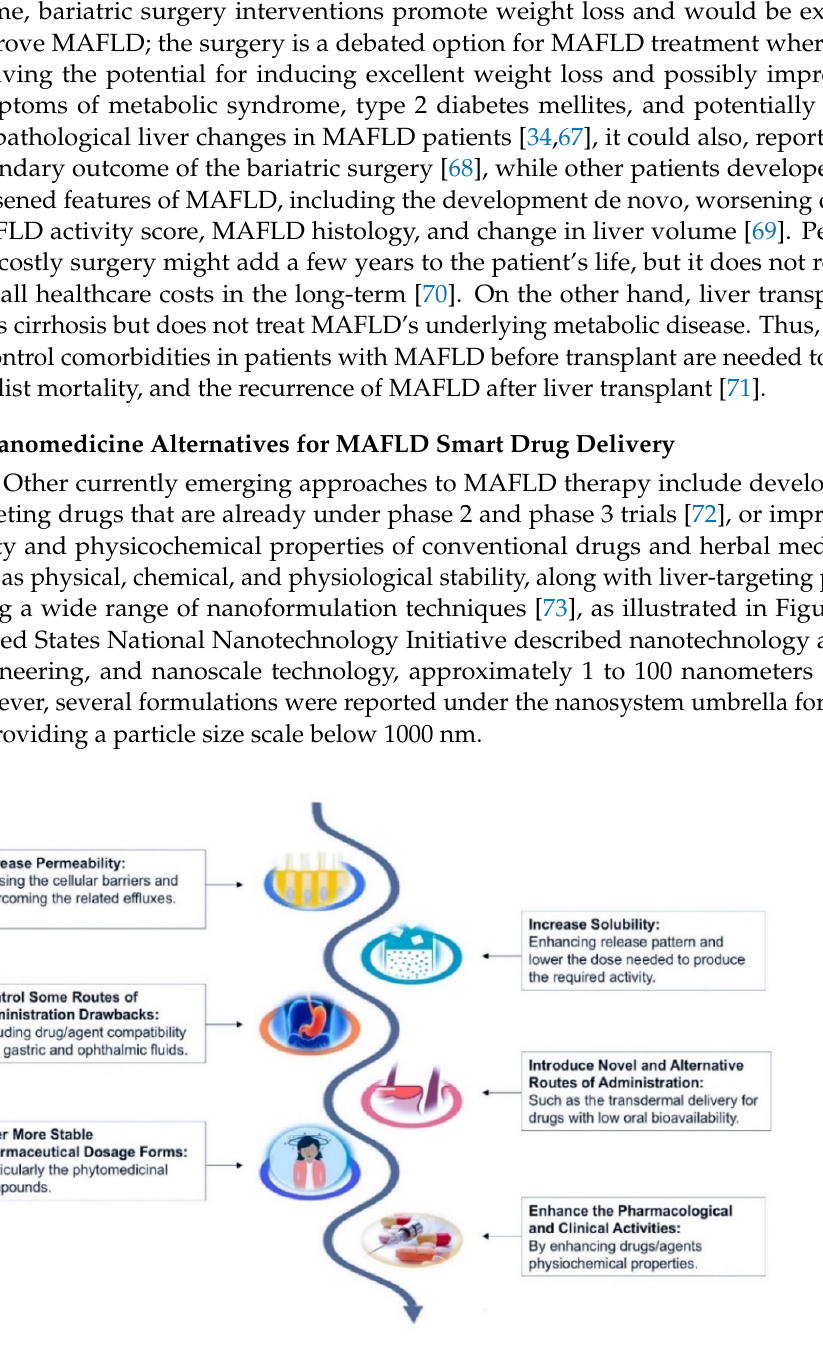
Figure 1. The main challenges that nanoformulations are overcoming to enhance drug/phyto- chemical